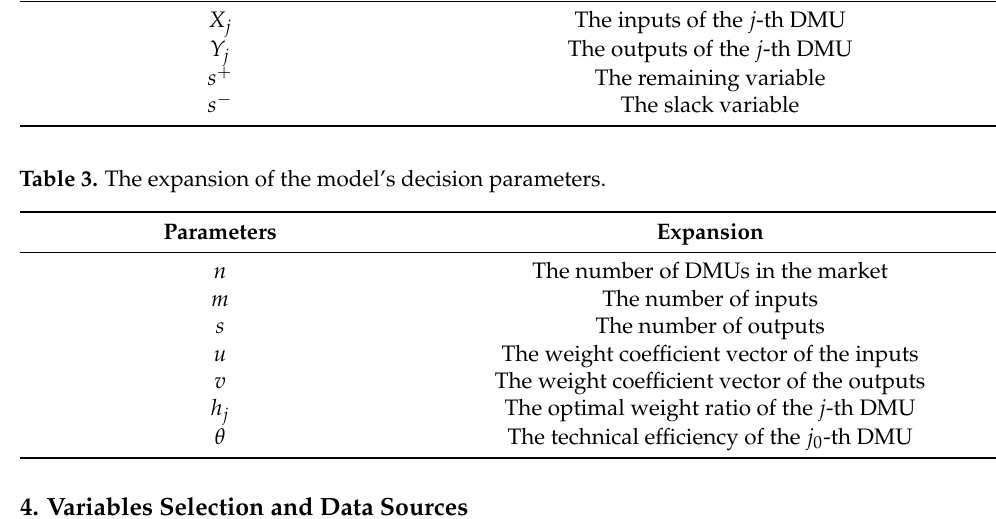
Table 2. The expansion of the model’s decision variables. Variables